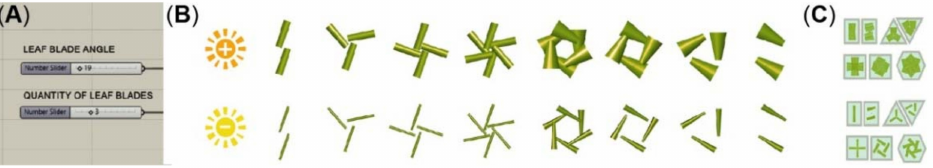
Figure 10. Parametric leaf-blade system: ( A ) parameters for replicating the modules of leaf-blade; ( B , C ) different positioning patterns, high (+) and low ( − ) radiation intensity. Source: